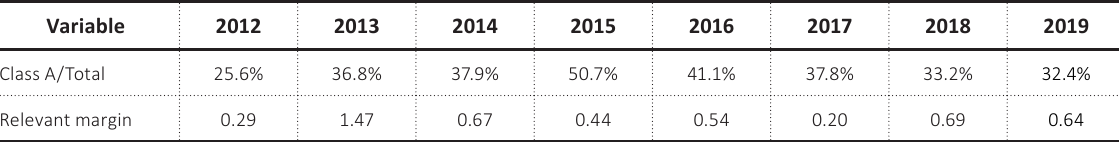
Table A5. Total number of banks, in each year, whose loans are